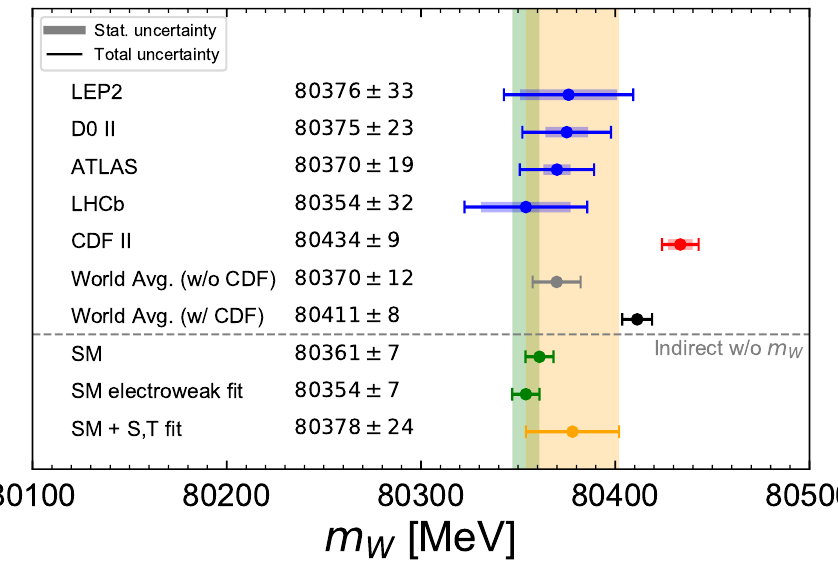
Figure 1 . A comparison of the new CDF measurement of m W (red) [28] with previous measurements (blue) [29–31], and a naive world average with (black) and without (grey) CDF. The values found in the Standard Model using fixed input parameters [32], or determined from an electroweak fit omitting measurements of m W [33], are shown in green. The orange band is the 1- σ range allowed in a two-parameter fit to the oblique electroweak precision parameters S and T [34, 35] made